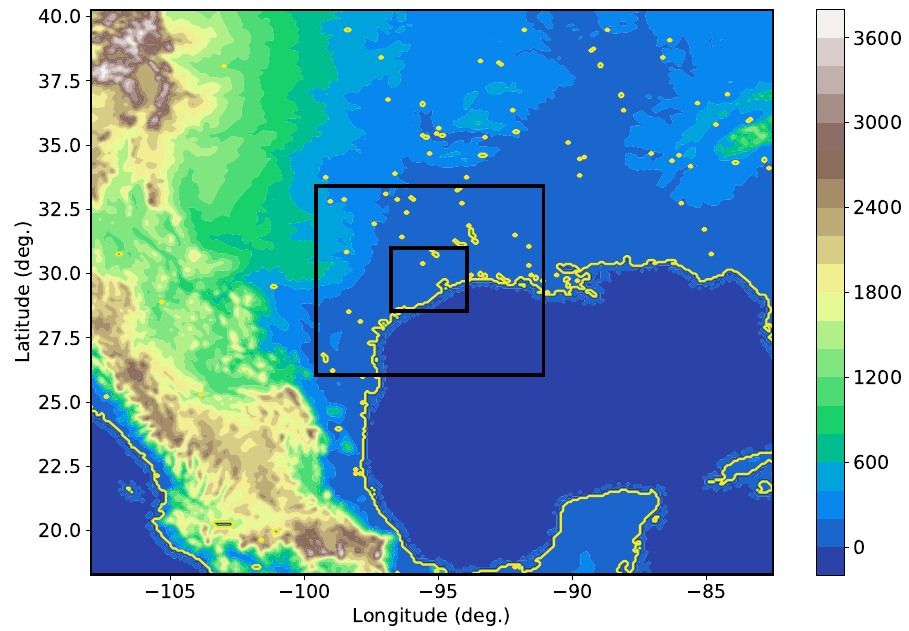
Figure 2. WRF model’s three nested domains (respective spacings of 9, 3, and 1 km) with resolved topography in color shades. All analysis of the simulations is carried out on the innermost